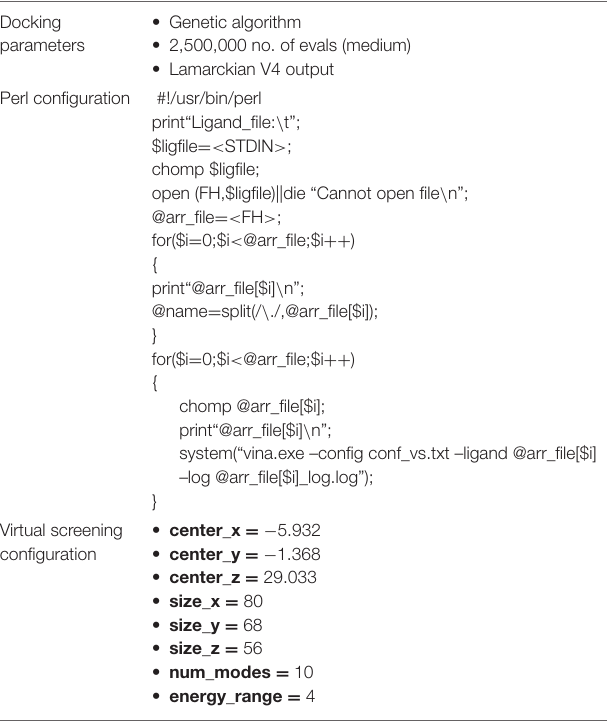
TABLE 1 | Blind docking simulation parameters and virtual screening configuration using Autodock Vina. Docking parameters